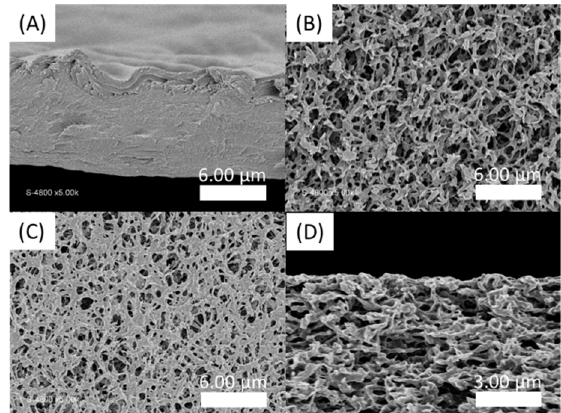
Figure 8. SEM pictures of PA-PSSNa films. ( A ) Cross section of the self-standing membrane formed by tape-casting of a PSSNa solution then covered with C 16 V 3 A 3 K 3 G-NH 2 solution; ( B ) Top view of virgin hydrophilic PVDF membrane; ( C ) Top view and ( D ) Cross section SEM images of the film deposited on hydrophilic PVDF by impregnation of PSSNa followed by C 16 V 3 A 3 K 3 G-NH 2 tape-casting.